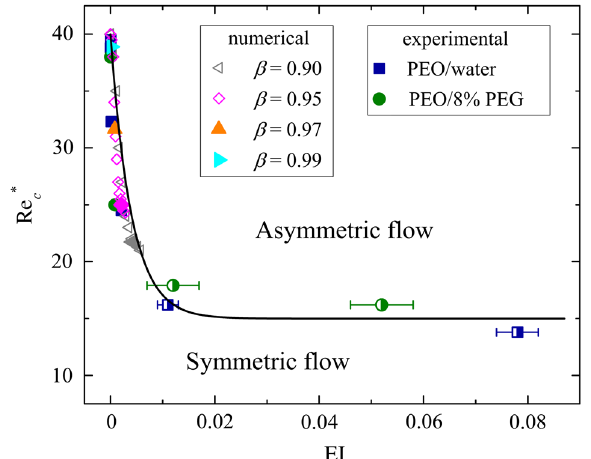
FIG. 10. Lower critical Reynolds number Re (cid:3) as a function of c the elasticity number El for inertia-dominated flow instabilities of low concentration PEO solutions in a cross-slot device with α ¼ 1 . For experimental data, closed symbols represent steady FIG. 11. The ratio of the parameters g and k as a function of El. instabilities, while half-closed symbols represent unsteady in- The dashed line indicates g ¼ 0 , where the transition would be stabilities. For numerical results, open symbols represent constant tricritical. Above the line the transition is supercritical; below the Wi line the transition is subcritical with , while closed symbols represent constant El simulations. eff